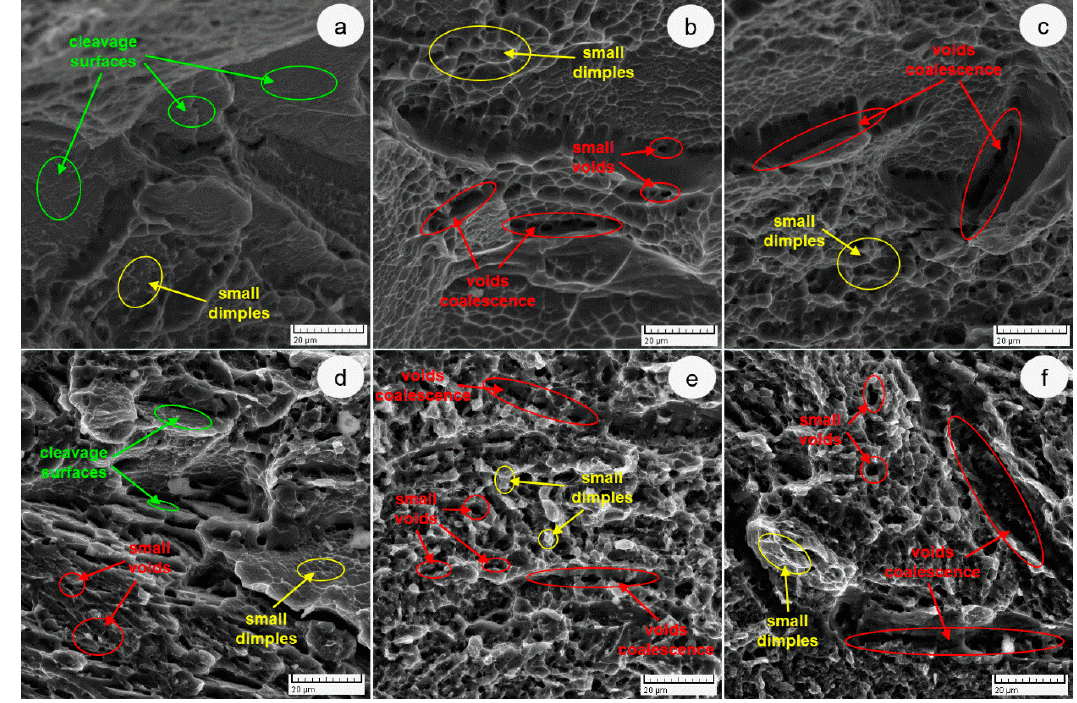
Figure 9. SEM-SE images of fracture surfaces after tensile testing of ( a ) solution treated at 800 °C (ST1) state; ( b ) solution treated at 900 °C (ST2) state; ( c ) solution treated at 1000 °C (ST3) state; ( d ) solution treated at 800 °C and aged at 600 °C (ST1 + A) state; ( e ) solution treated at 900 °C and aged at 600 °C (ST2 + A) state; ( f ) solution treated at 1000 °C and aged at 600 °C (ST3 + A) state.